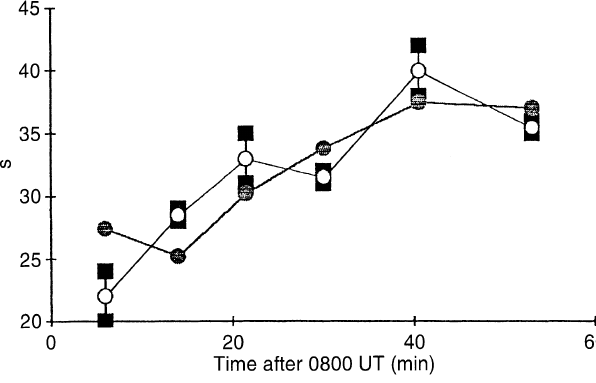
Fig. 6. The 0800 to 0900 UT, 18 June event: periods of pulsations supposedly originating from upstream waves. The range of periods observed along the array is indicated for each event when UW-type pulsations were identified. The IMF magnitude is represented ( full circles , solid line ) as 255/ B , and shifted backward in time by